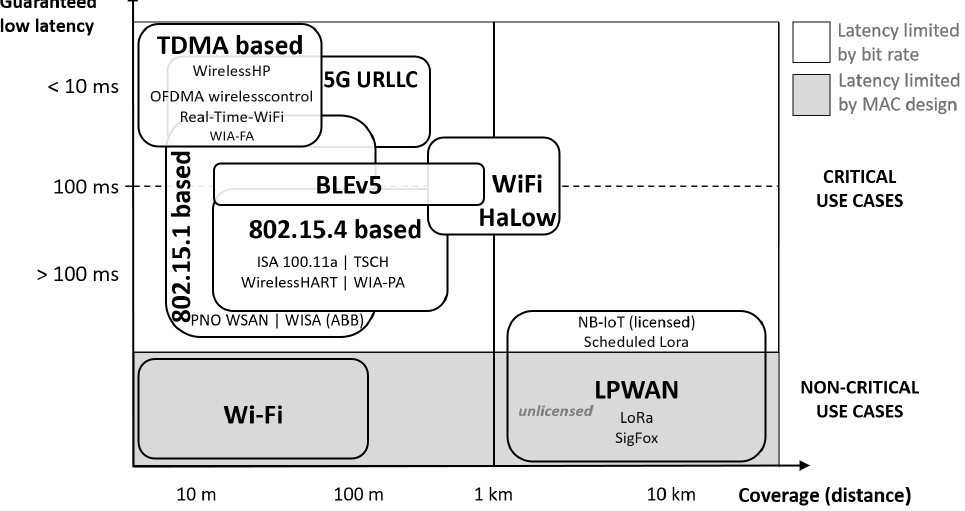
Figure 2. Different wireless technologies have different range/latency capabilities. This article discusses the trade-offs in mid-range technologies that could provide coverage of an entire industrial site (black boxes) with sufficiently low